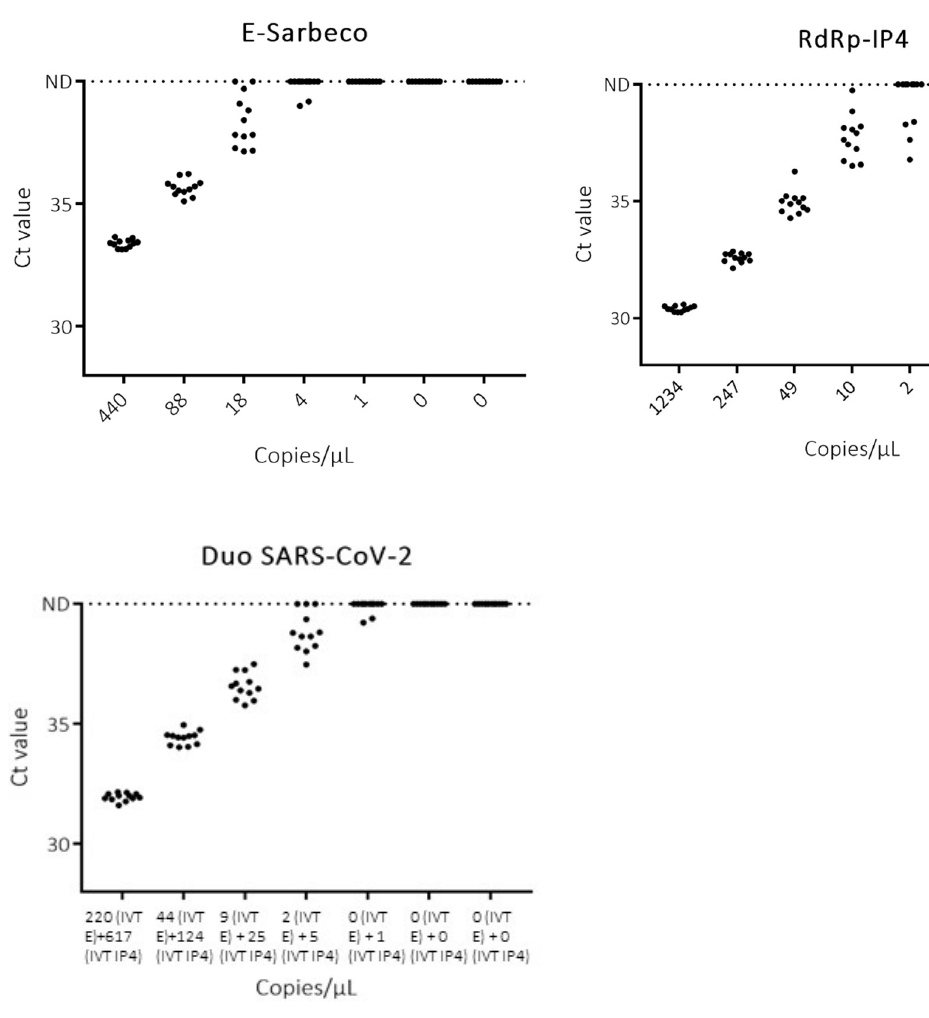
Figure 3. Detection of dilutions of IVT RNA E-Sarbeco and RdRp-IP4 with E-Sarbeco, RdRP-IP4 and duo SARS-CoV-2 assays. ND: not detected.